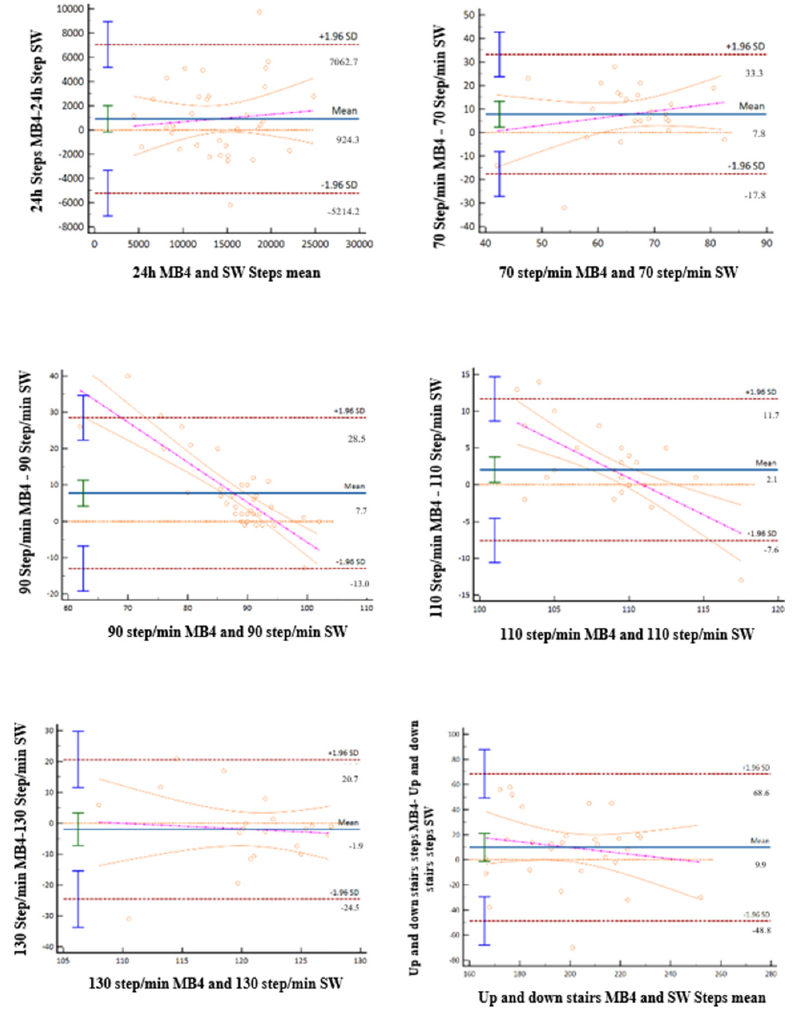
Figure 5. Bland-Altman plots in the process of calculating the concordance between MB4 and SW in the different gait protocols.